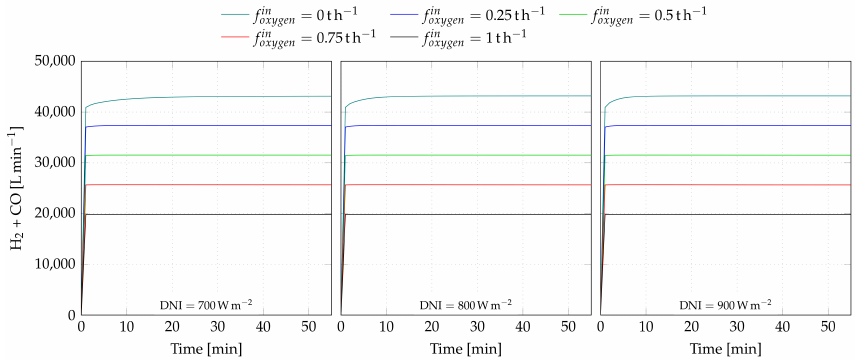
Figure 6. Syngas (H 2 + CO) production for various oxygen flow rates and DNI levels.